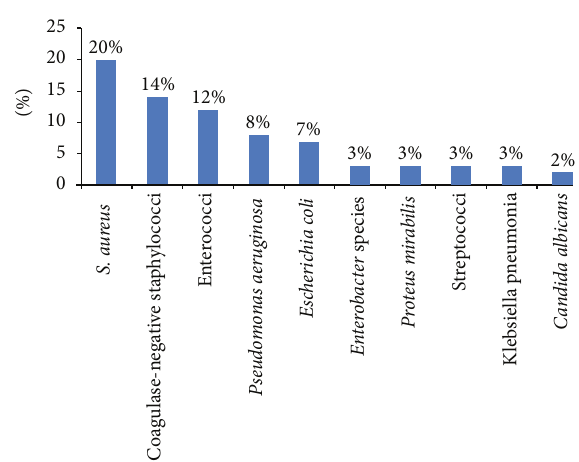
Figure1: The10frequently identified types of pathogens responsible for surgical site infections in hospitals (adopted from